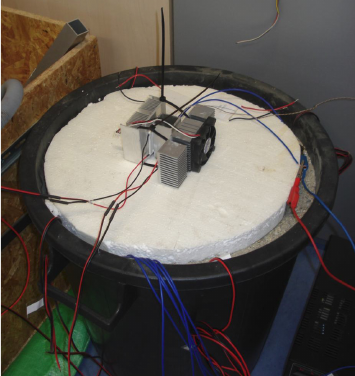
Figure 12. Photography of modified experimental setup.